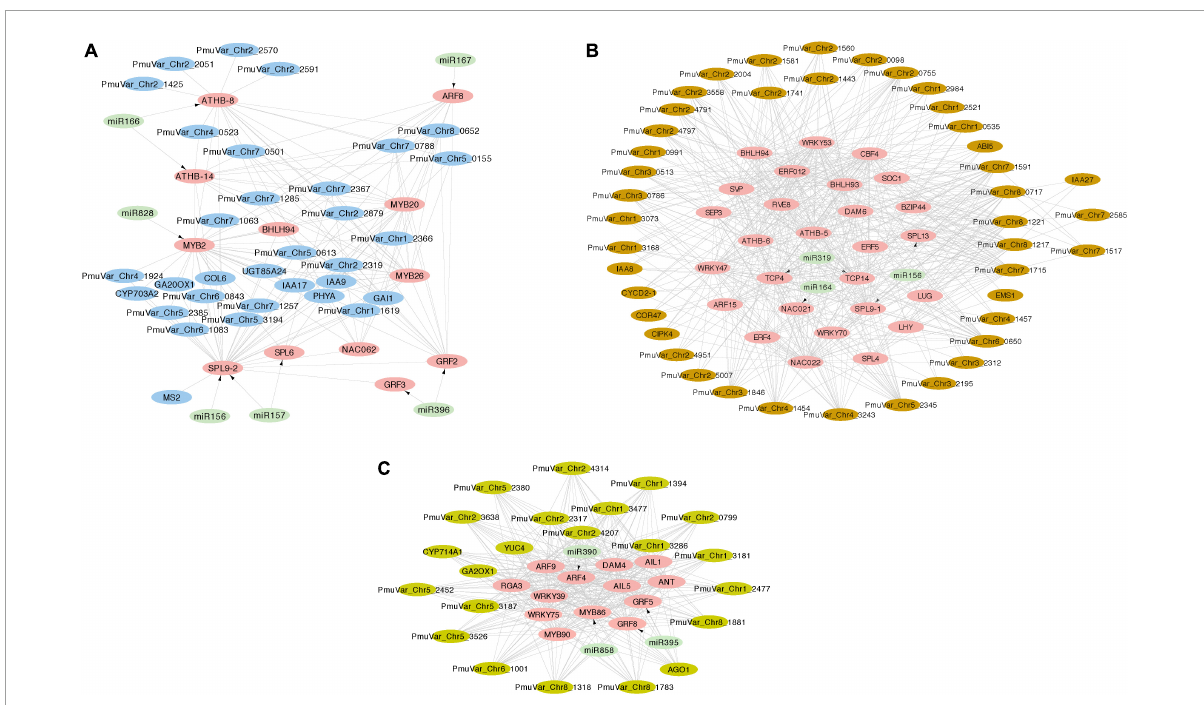
FIGURE8 Integrated miRNA-TF regulatory networks of three co-expression gene modules. The transcription factors and target genes of DEmiRs were identified from module blue (A) , module brown (B) , and module darkseagreen4 (C) . The pink nodes represent hub transcription factors, the light green nodes represent miRNAs, and the other putative regulated genes were colored with their corresponding module color. The arrows represent the regulation relationship between miRNAs and their target TFs. The edges connecting TFs and other genes represent co-expression relationship.